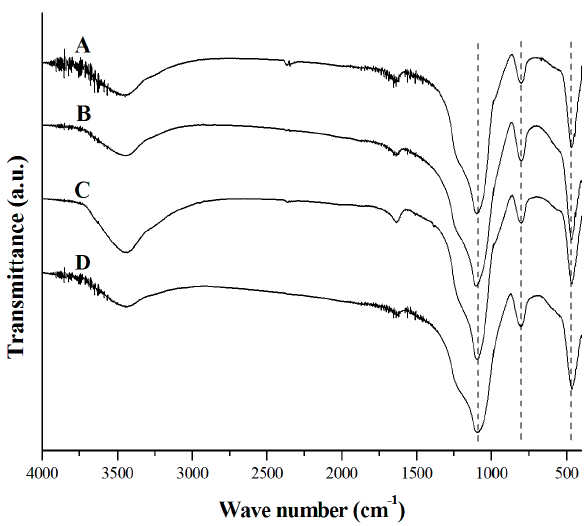
Figure 4. FTIR spectra of silica powders. ( A ) horsetail, ( B ) common reed, ( C ) rye straw, ( D ) wheat straw. The characteristic bands for SiO 2 are marked with dashed lines.